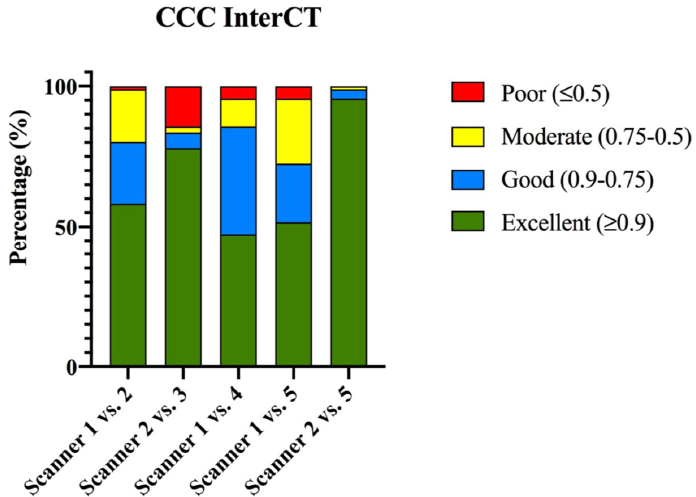
Figure 5. Histogram of the CCC value for the radiomic features when comparing image acquisition with different scanners.